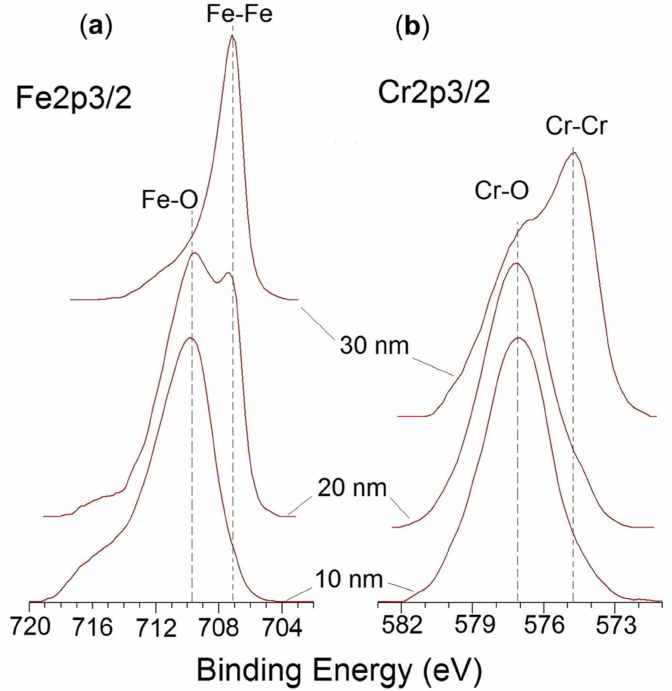
Figure 5. Fe2p3/2 ( a ) and Cr2p3/2 ( b ) XPS spectra on various depths (indicated near curves) of the Al + ions irradiated